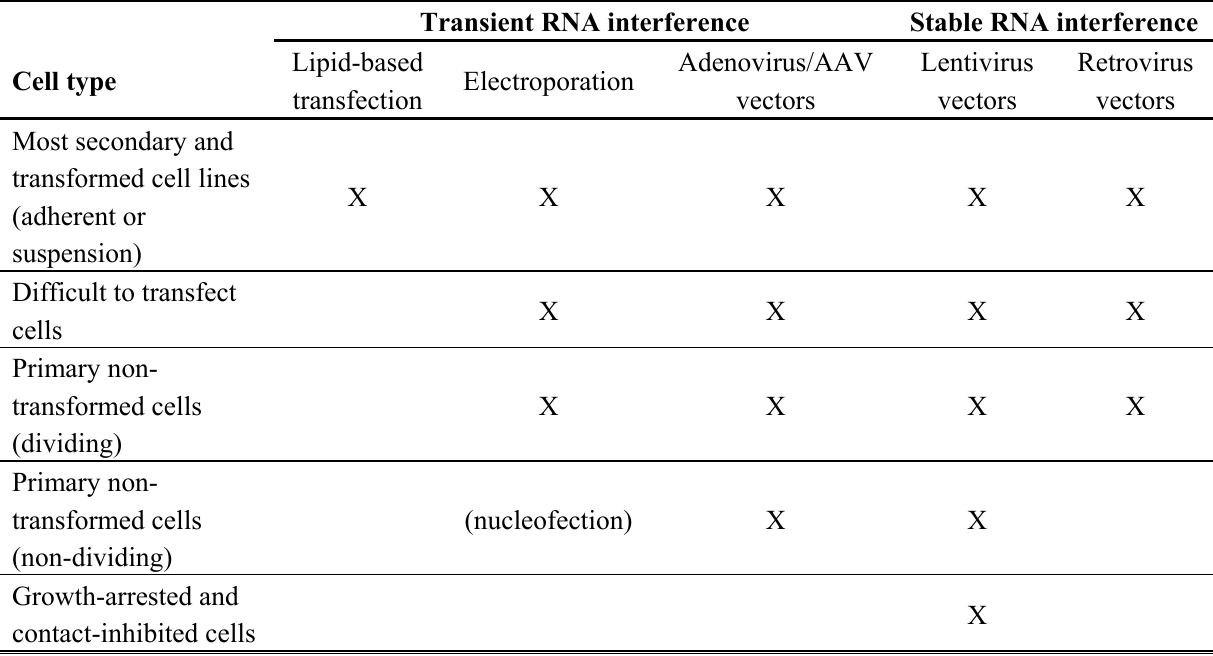
Table 1. RNAi delivery systems for different cell